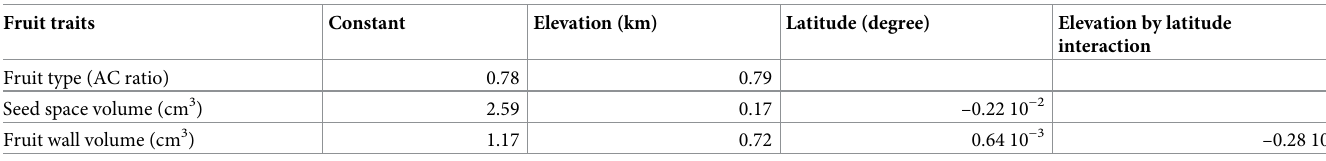
The appeared coefficients are significant based on model selection by Akaike’s Information Criterion